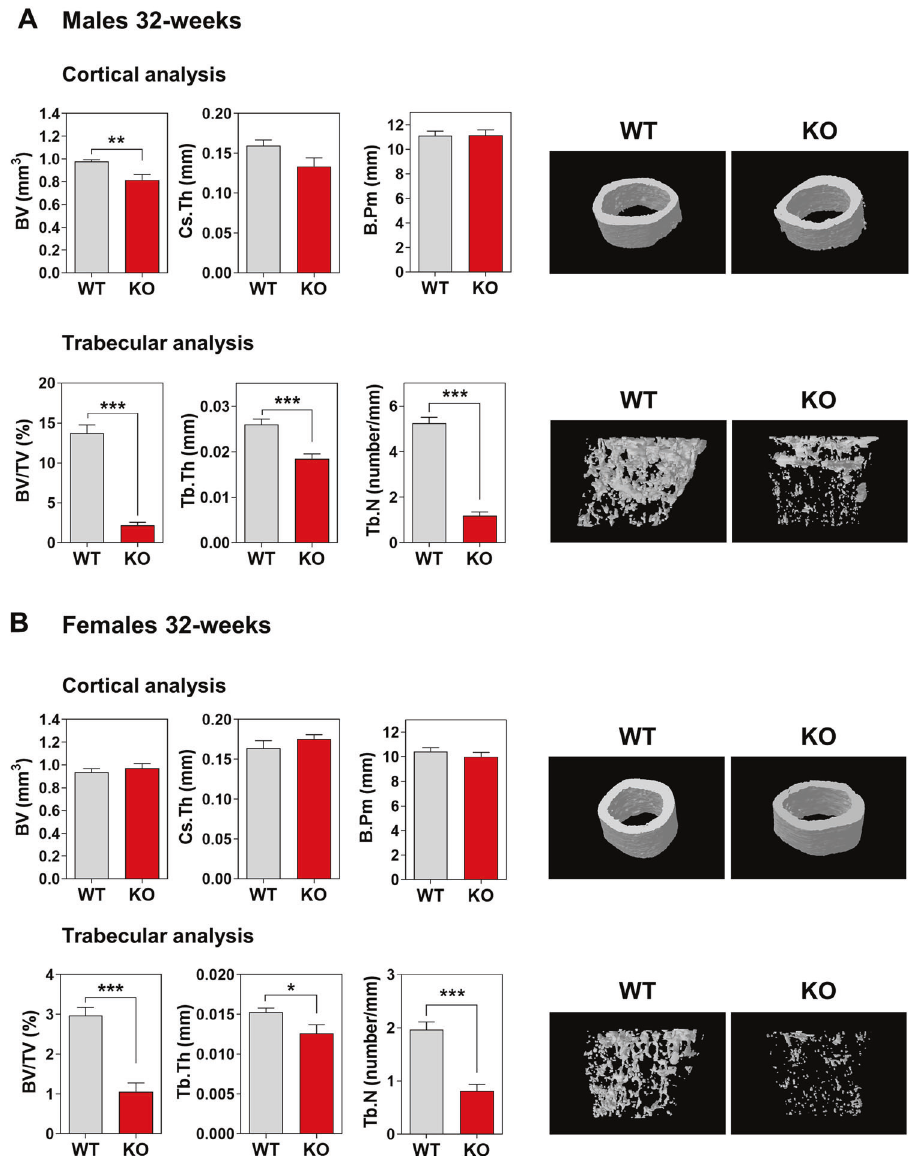
Fig. 6 HERC1 de fi ciency causes osteopenia in adult mice. Bone composition by micro-CT analysis of 32-week-old mice. Cortical and trabecular analysis of distal femurs from male ( A ) and female ( B ) mice. Representative images are shown. Data ( n = 6 – 12) are expressed as mean ± SEM. Signi fi cant differences are relative to WT of the same sex. * p < 0.05; ** p < 0.01; *** p < 0.001. BV bone volume, B.Pm bone perimeter, BV/TV bone volume over total volume, Cs.Th cortical thickness, Tb.N trabecular number, Tb.Th trabecular thickness, KO knockout, WT